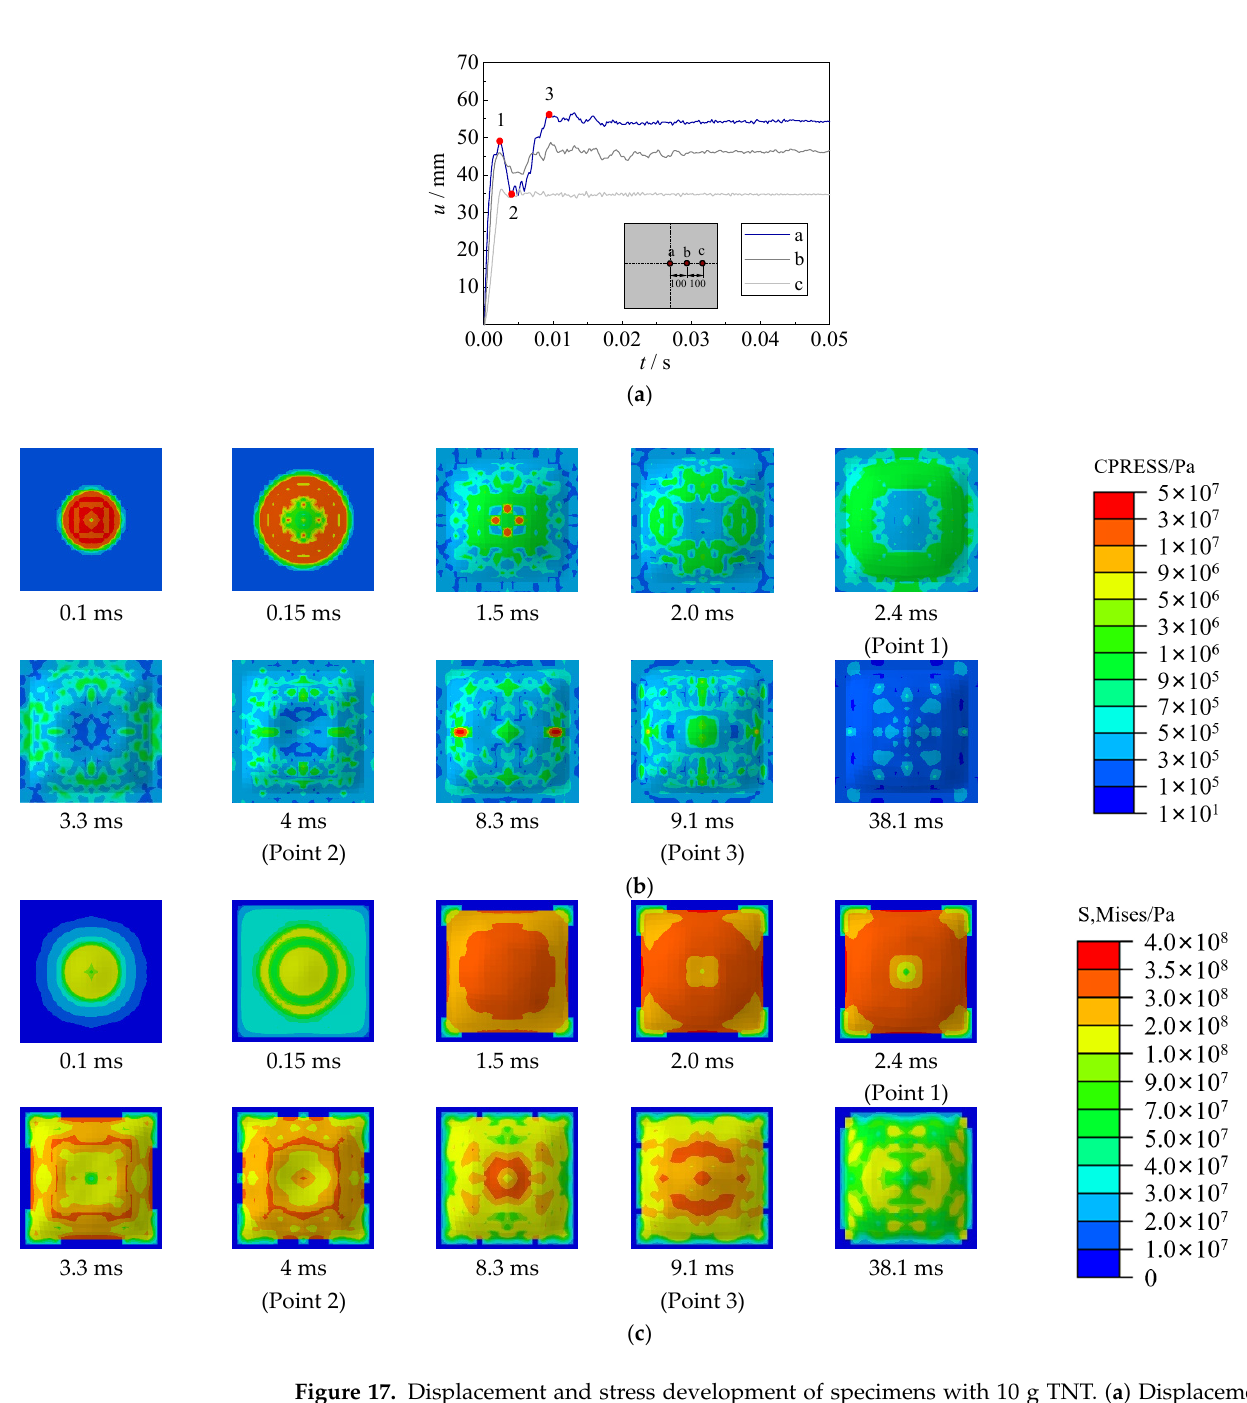
Figure 17. Displacement and stress development of specimens with 10 g TNT. ( a ) Displacement time–history curve. ( b ) Contact stress (CPRESS). ( c ) von Mises stress of steel sheet (S,Mises).